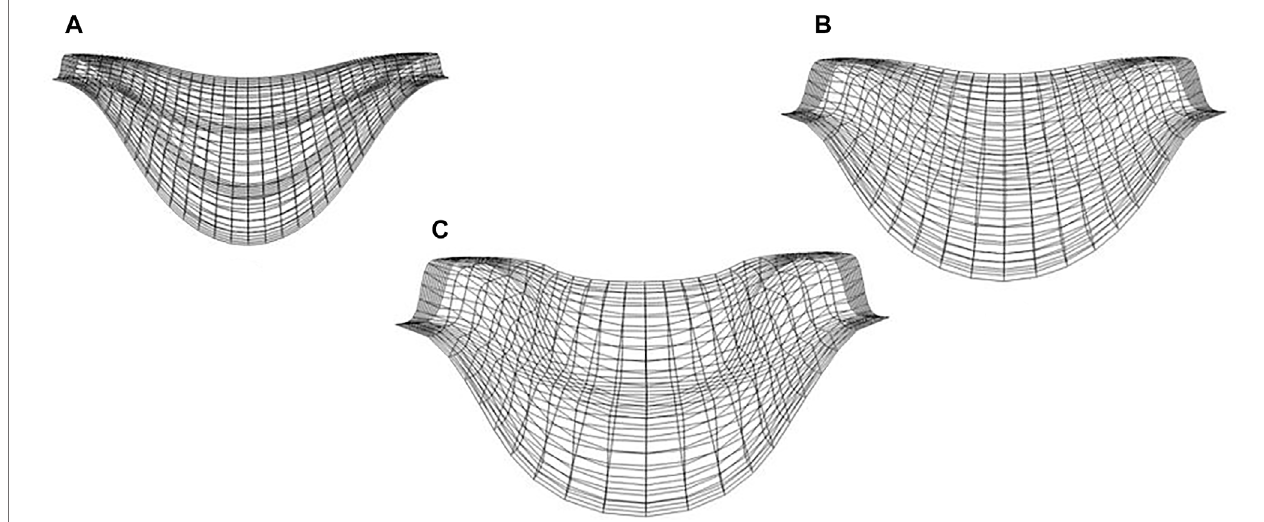
FIGURE 9 | Randomly selected realizations of the point-bar reservoir geometries used for performing EnKF. Perturbation of the angular displacements of the sine generation function used to represent the lateral migration of the points bars at (A) ω = 19.4 ° (B) ω = 45 ° and (C) ω = 36 ° . In the EnKF, only the geometry was altered, reservoir properties like porosity and permeability were not changed. The fi gure is displayed in the Computer Modeling Group (CMG) Software.